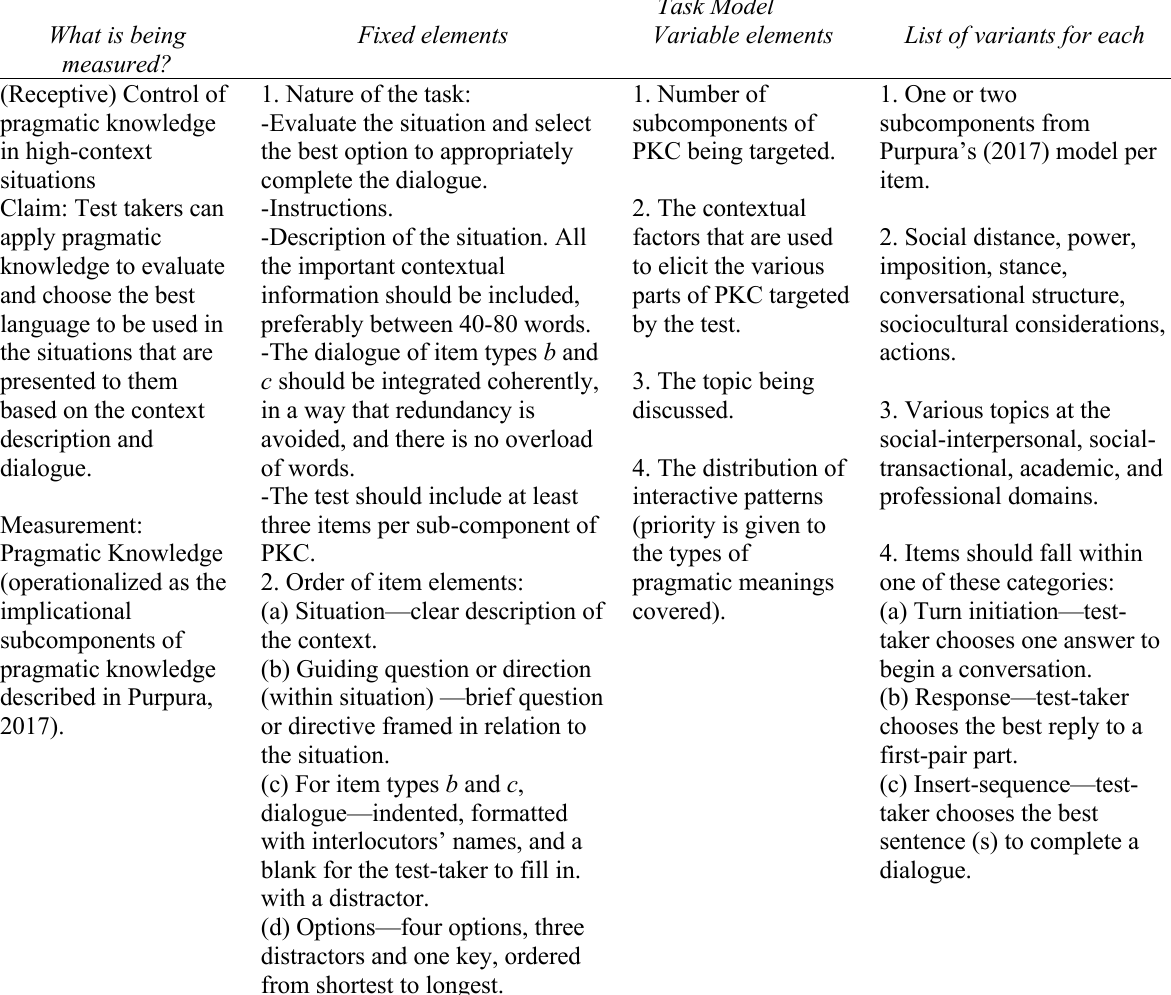
Task Shell for the Multiple-Choice Test of Pragmatic Knowledge